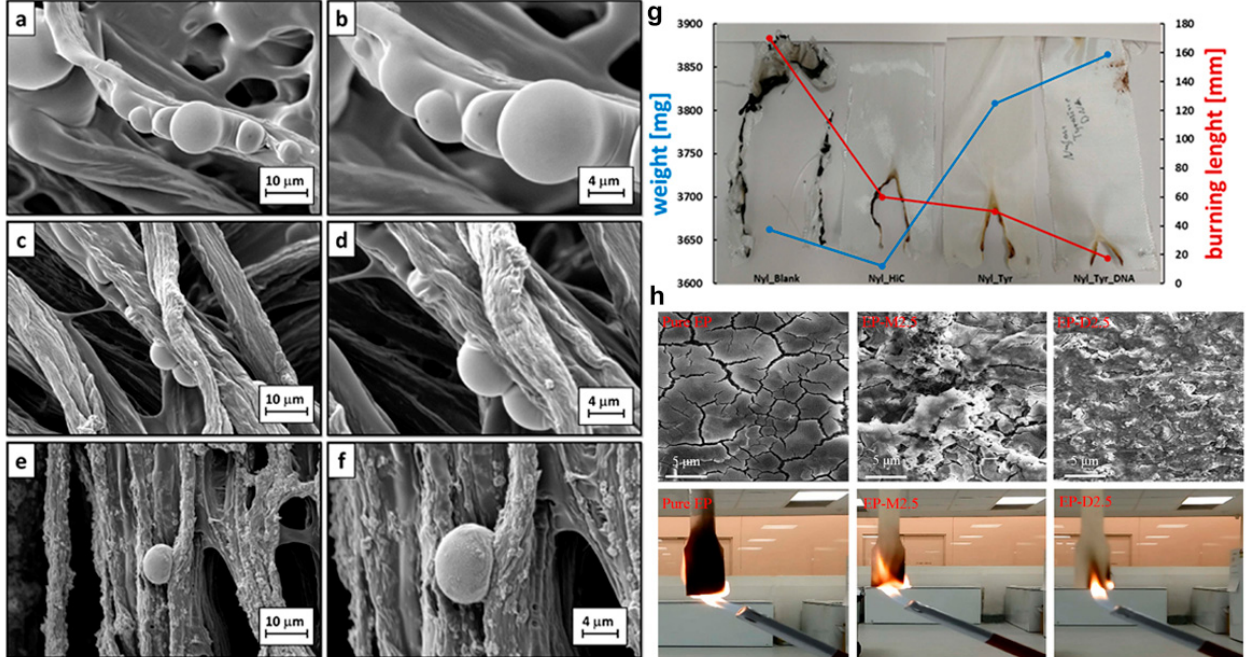
Figure 3. SEM images of cotton fabrics, coated with 10 polydiallyldimethylammonium chloride (PDAC)/DNA bilayers without ( a , b ) and with addition of 0.1% ( c , d ) and 1.0% ( e , f ) of hydrotalcite, after its exposure to a flame retardant test. Reproduced from [102] under the Creative Commons Attribution (CC BY) license cutinase (Nil_HiC) followed by treatments with tyrosine (Nyl_Tyr) and DNA (Nyl_Tyr_DNA) after a flammability test ( g ). The lines indicate the changes in the remaining fabric weight (blue) and burning length (red) depending on the treatment. Reproduced from [92] under the terms of the Creative Commons Attribution License (CC BY). Copyright 2019